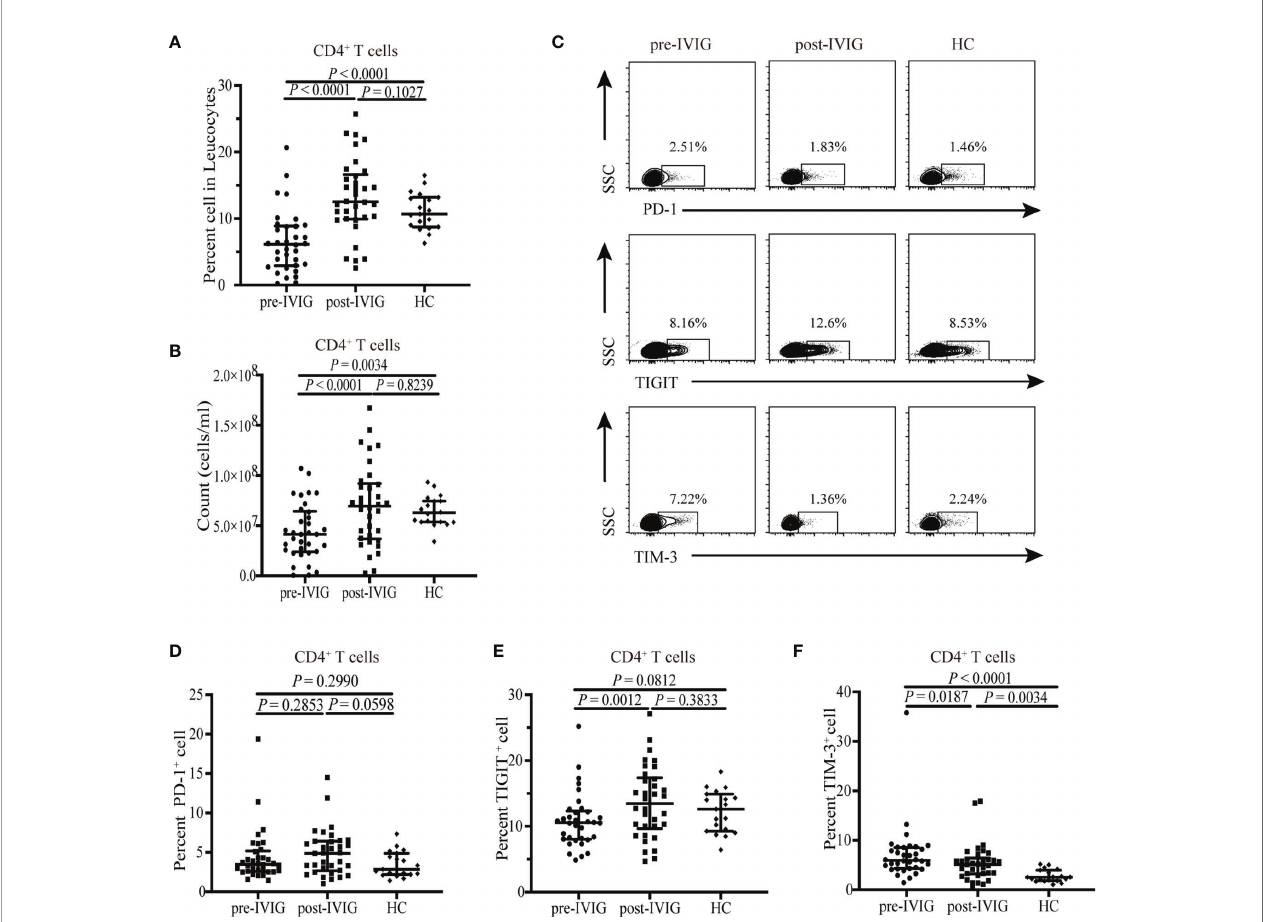
FIGURE 3 | Flow cytometry detection of the expression of PD-1, TIGIT, and TIM-3 on CD4 + T cells from healthy control (HC) (n = 19) and KD patients pre- and post-IVIG treatment (n = 34). Graphs show (A, B) Percentage and number of CD4 + T cells among peripheral blood leucocytes in KD patients and HCs. (C) Representative dot plots of PD-1, TIGIT, and TIM-3 are shown on gated CD4 + T cells. (D) Expression of PD-1 on CD4 + T cells in patients with KD and HCs. (E) Expression of TIGIT on CD4 + T cells in patients with KD and HCs. (F) Expression of TIM-3 expression on CD4 + T cells in patients with KD and HCs. Horizontal bars represent median values, and error bars represent the interquartile range. MFI, mean fl uorescent